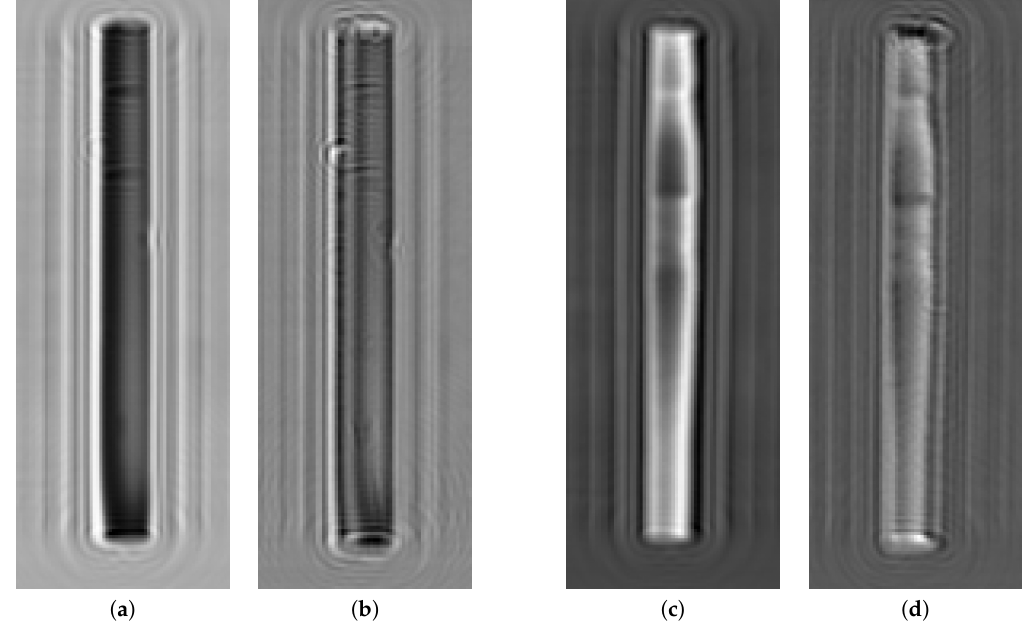
Figure 4. Microwave holograms from rail fragments: ( a , b ) rail fragment #1, frequency 24.0 GHz, quadrature components in parallel and perpendicular receive polarizations, respectively; ( c , d ) rail fragment #2, frequency 22.2 GHz, quadrature components in parallel and perpendicular receive polarizations, respectively. The incident wave is polarized horizontally and directed along the rail fragments in all